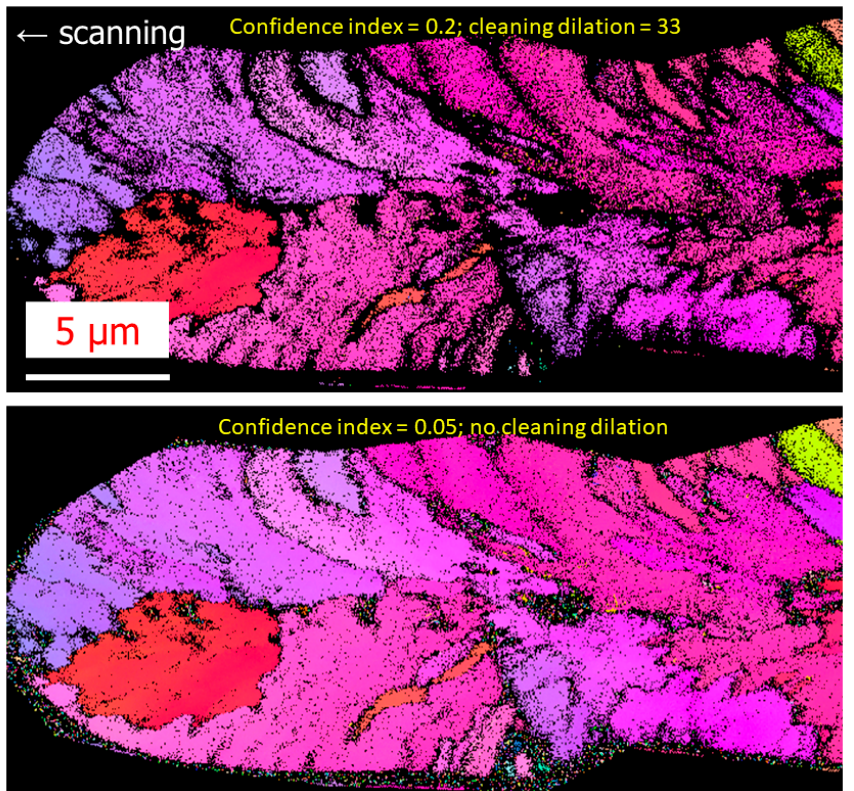
Figure 5. Comparison between two EBSD pictures but with smaller confidence index and with/without cleaning procedures using OIM TM